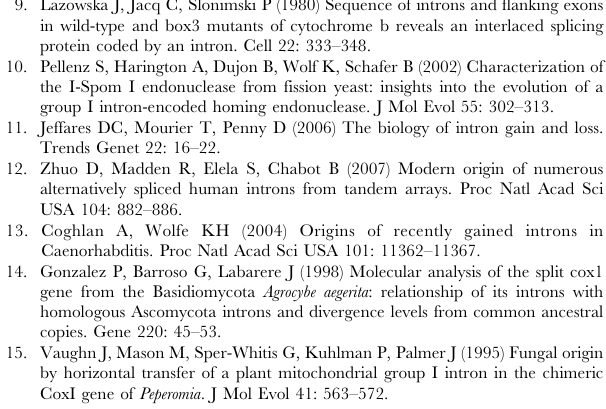
Table S1 Primers used for intron-specific PCR amplification Figure S1 Modification of the sliding intron position or phase. (A) The phase of intron Sc5 was modified based on one nucleotide shifting of the exon/intron sequence. (B) The phase of intron Gi3 was modified based on two nucleotide shifts that altered one codon. (C) Sliding introns can’t be modified to same position or phase. Lowercase letters indicate intron sequences, and uppercase letters represent the flanking exon sequences, the larger uppercase